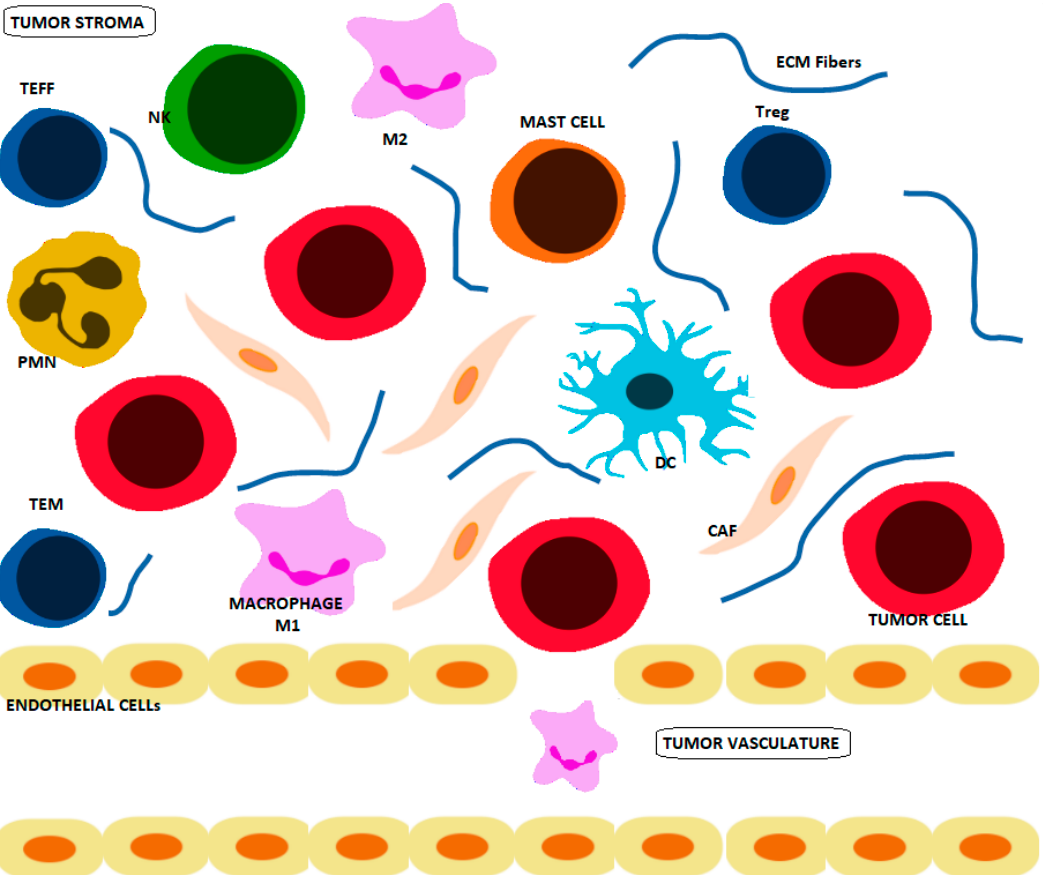
Figure 1. The cell types within the TME include cancer cells, immune cells and stromal cells. The immune cells in the TME include natural killer (NK) cells, dendritic cells (DC), macrophages (M1 and M2), polymorphonuclear leukocytes (PMN) (including neutrophils, eosinophils and basophils), mast cells and T cells (Regulatory T cells (Tregs), effector T cells (TEFF) and memory T cells (TMEM)). The stromal cells include cancer-associated fibroblasts (CAFs), which are embedded in the TME with Extracellular Matrix (ECM) fibers.